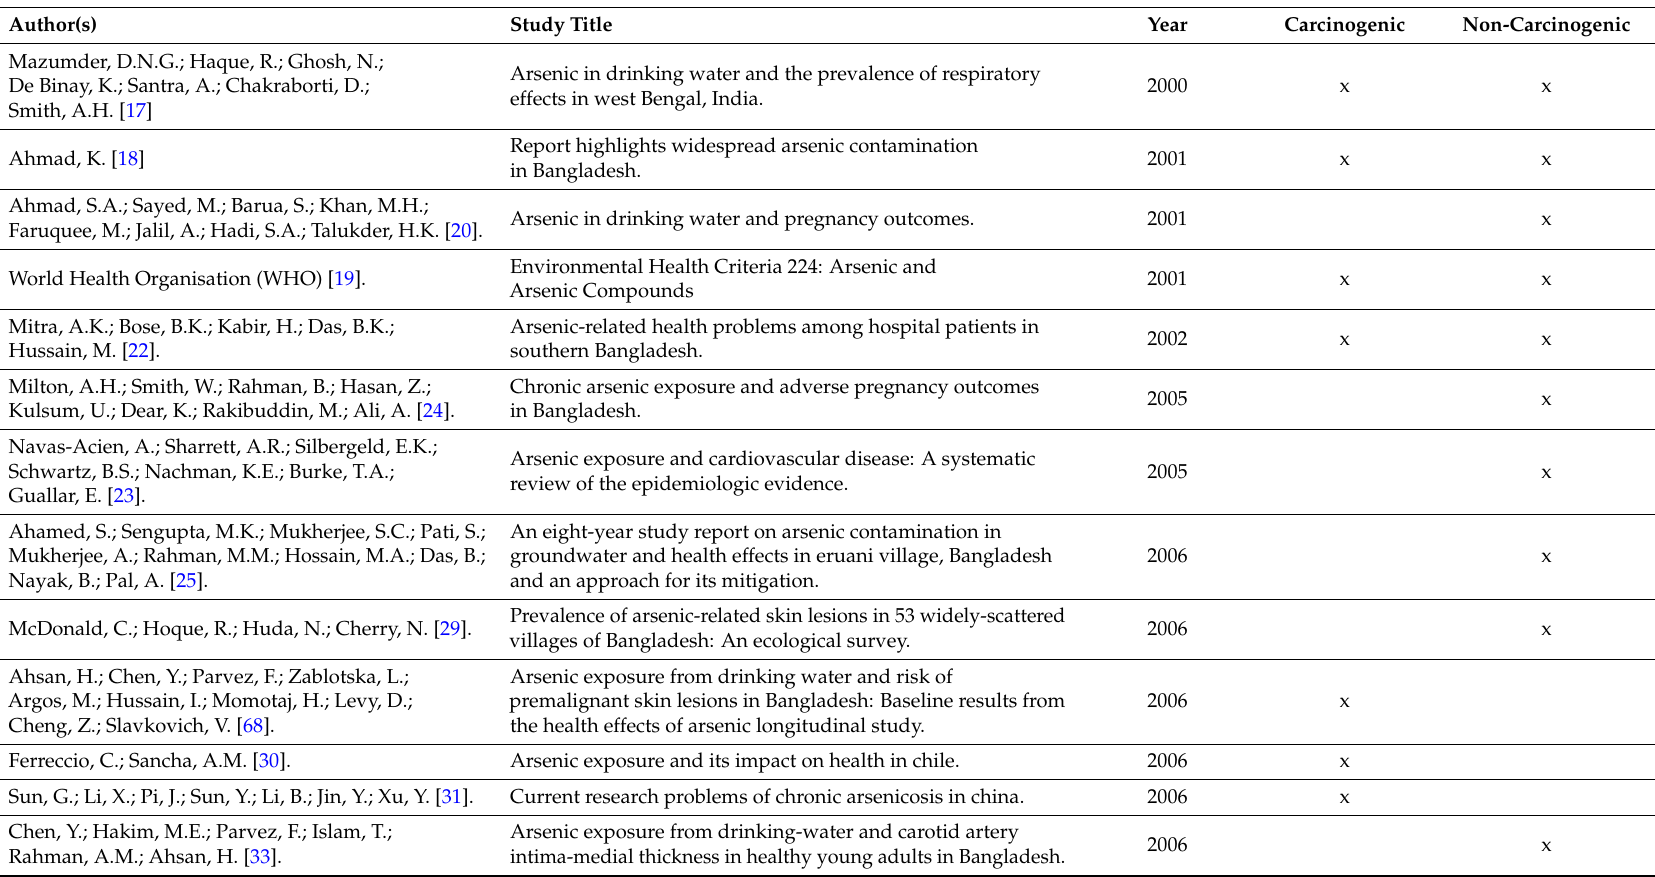
Table 2. Review matrix of health consequences of arsenic